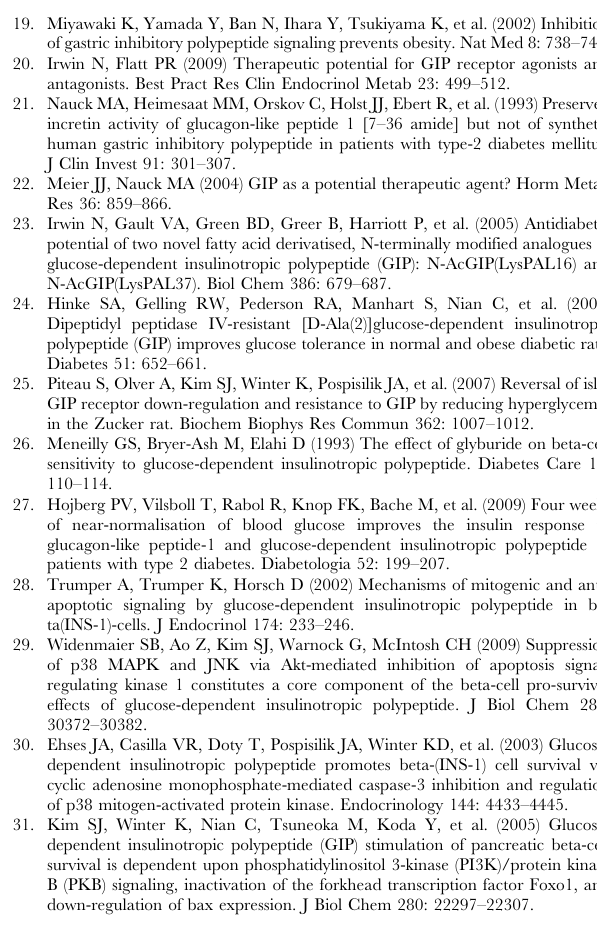
Figure S1 Representative sections of pancreases collected from untreated rats and rats treated with PBS or D-GIP 1–30 + STZ.